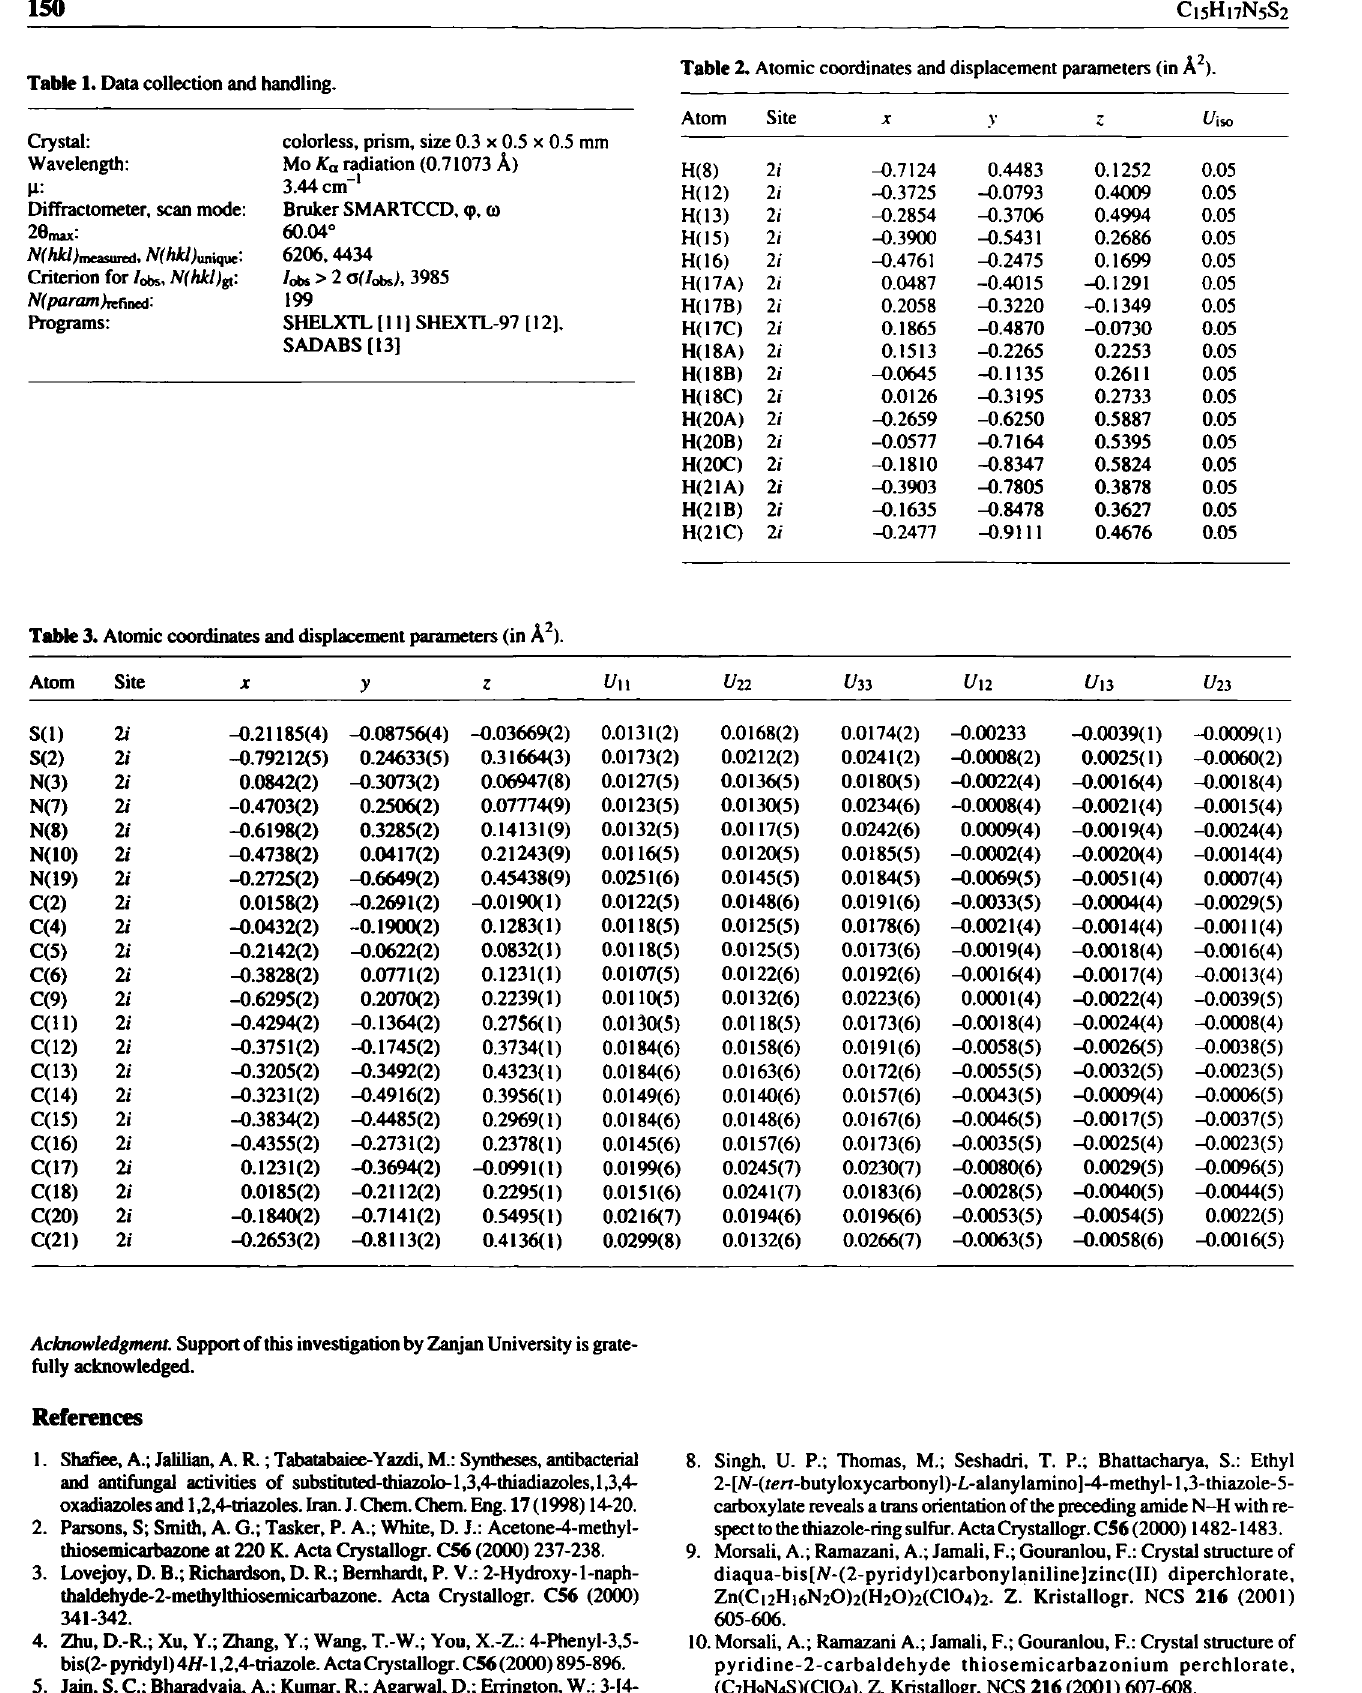
Table 1. Data collection and handling.